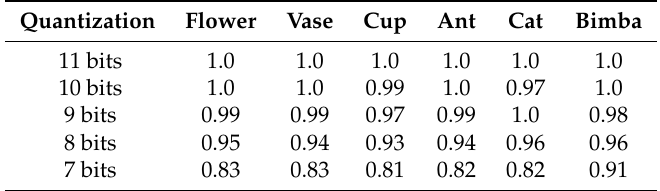
Table 8. Watermark robustness against quantization measured in terms of correlation.